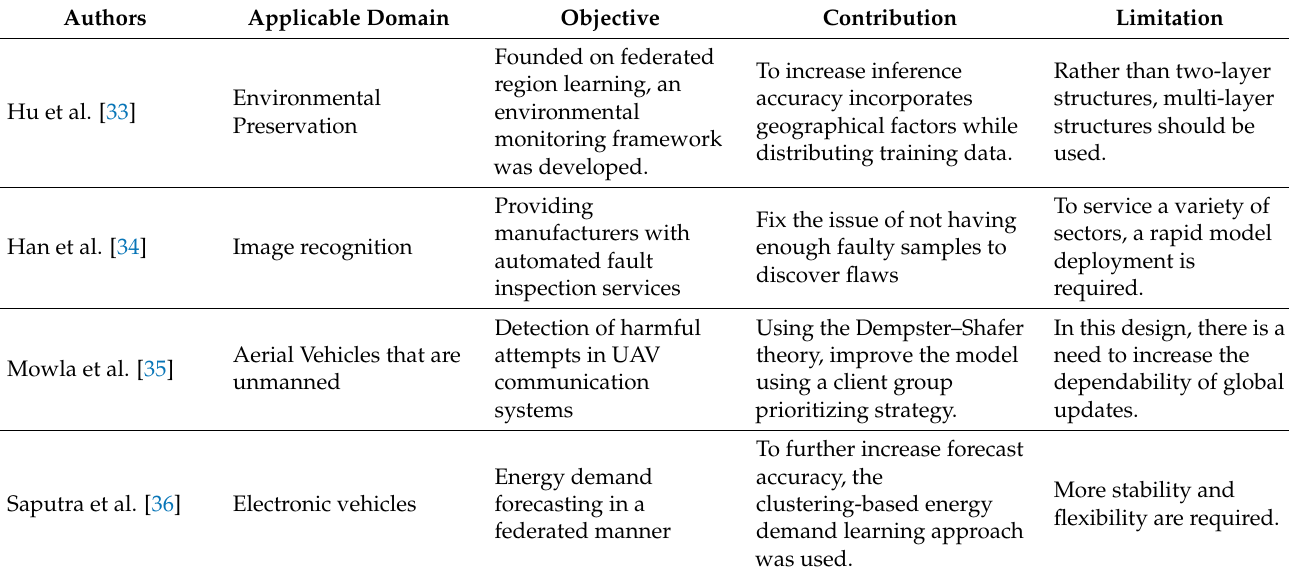
Table 8. Summary of FL application in industrial